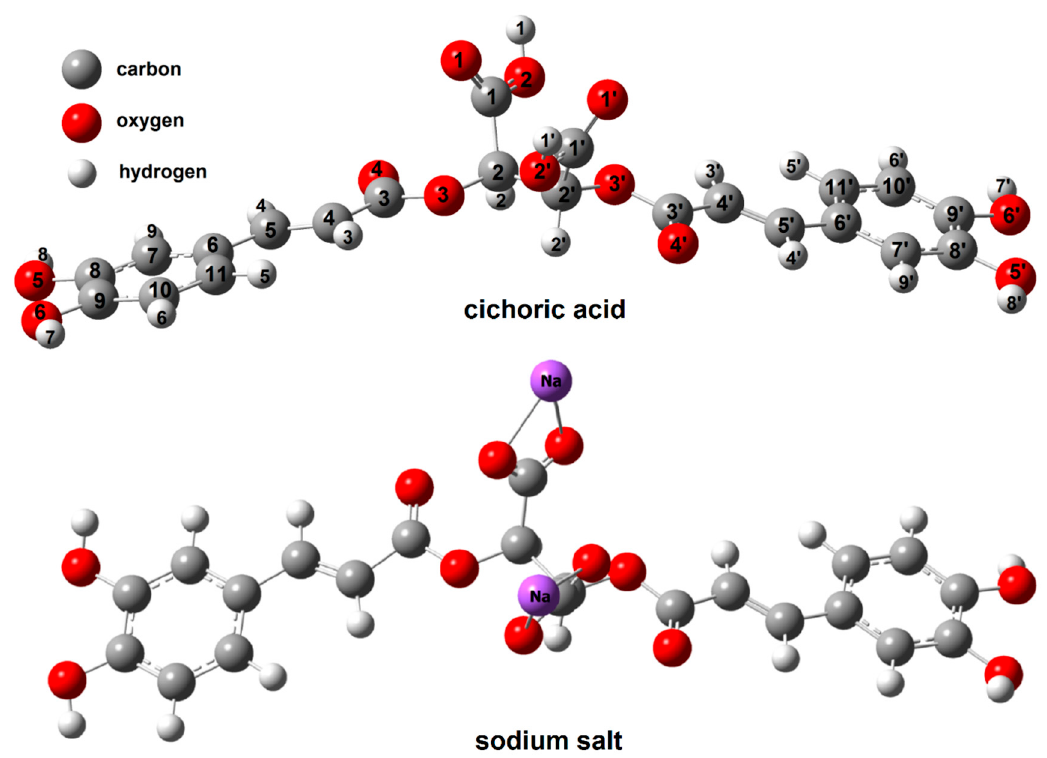
Figure 3. The structure of cichoric acid and sodium cichorate calculated in HF/6-311++G(d,p).